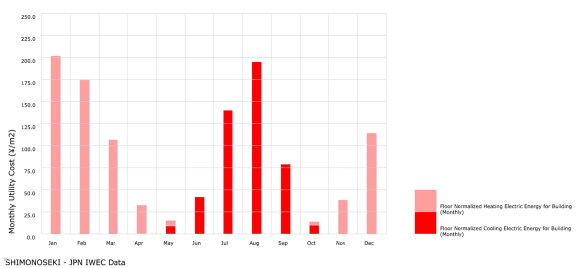
Fig. 10. Monthly utility costs for minimum UTCI